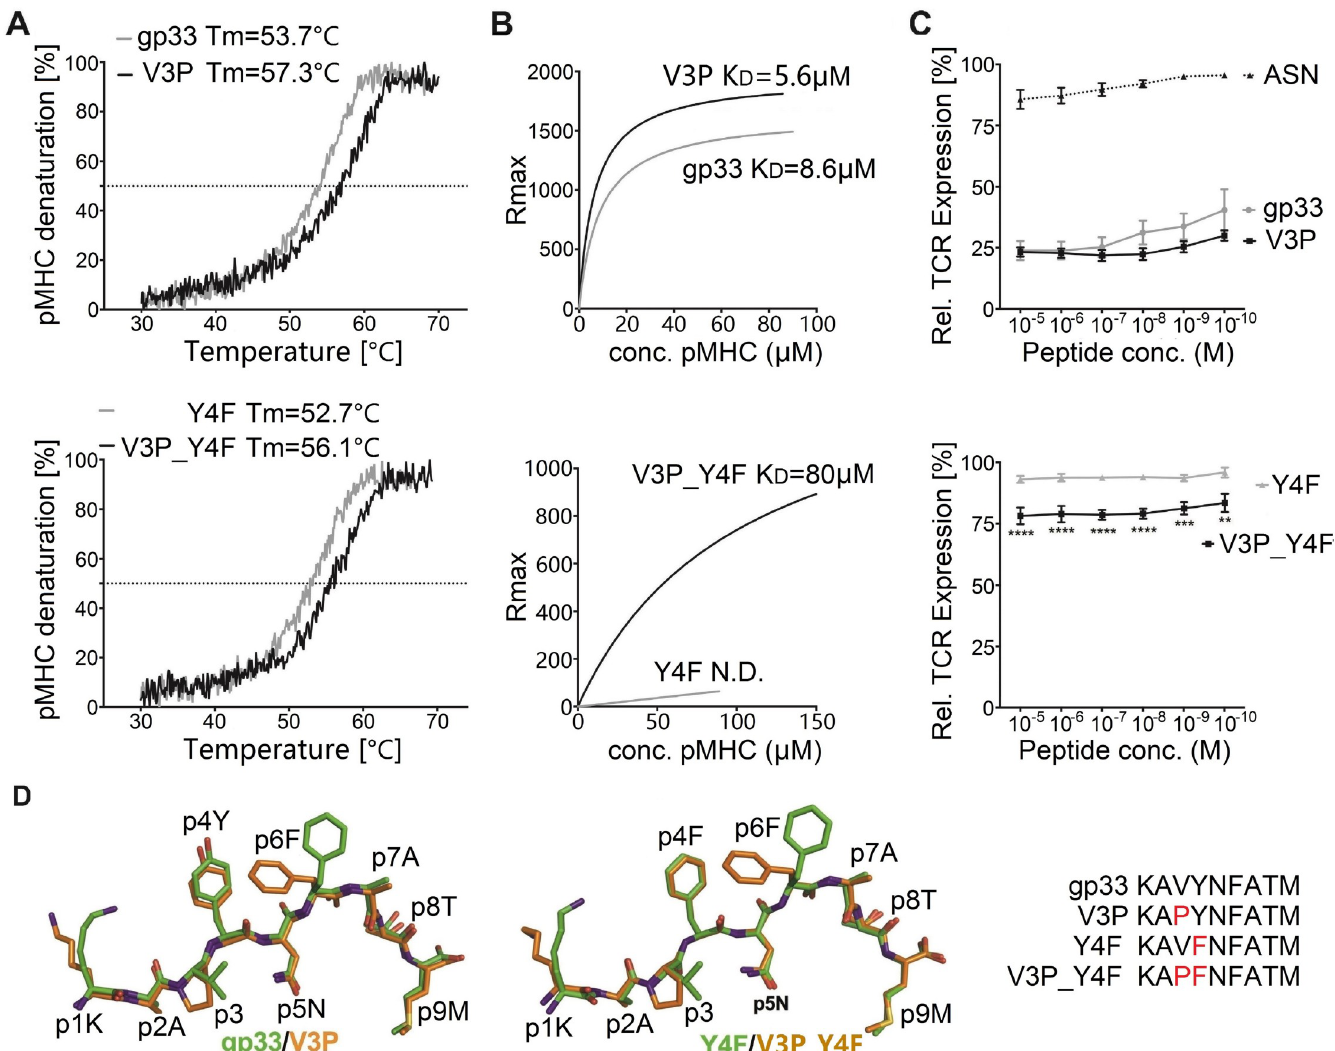
Fig 1. The p3P modification enhances pMHC stability without altering structural conformation, reestablishing TCR recognition. A. The p3P modification increases pMHC stability. CD melting curves of H-2D b /gp33 and H-2D b /V3P (upper panel), and H-2D b /Y4F and H-2D b /V3P_Y4F (lower panel). Melting temperatures (T m ) corresponding to 50% protein denaturation are indicated. B. The soluble TCR P14 binds to the APL V3P_Y4F. In contrast to Y4F, V3P_Y4F is bound by P14. Binding affinity of the soluble TCR P14 to each pMHC was measured using SPR. K D values are indicated. C. The p3P modification increases TCR internalization. TCR downregulation was measured following exposure of P14 T cells to H-2D b in complex with each peptide at indicated concentrations on RMA cells. CD3 + CD8 + CD4 - and V α 2 + cells were gated to quantify TCR internalization and p values calculated by using two-way Anova with Turkey’s multiple comparison test. ���� represents p < 0.0001; ��� 0.0002 and �� 0.0018. The H-2D b -restricted Influenza-derived peptide ASNENMETM (ASN) was used as negative control. D. The p3P modification does not alter the conformation of the backbone of APLs compared to native counterparts. Superposition of the crystal structures of H-2D b /V3P and H-2D b /V3P_Y4F with H-2D b /gp33 and H-2D b /Y4F demonstrates that the p3P modification does not alter backbone conformations. Significant conformational changes are only observed for the side chains of peptide residues p1K and p6F following the p3P substitution. lysis. CD8 + T cells, isolated from spleens of na ï ve or gp33-immunized P14 transgenic mice (P14-tg), were co-cultured with RMA cells pulsed with each peptide. Peptides gp33, V3P and V3P_Y4F induced significant production of TNF and IFN γ , as well as CD107a expression, while Y4F failed to induce any P14 T cell response (S3 Fig). Lysis of RMA cells by P14 T cells was also enhanced with V3P_Y4F compared to Y4F (S3 Fig). In conclusion, p3P-modification of the immune escape variant Y4F re-establishes in vitro recognition by P14 T cells (S3 Fig).